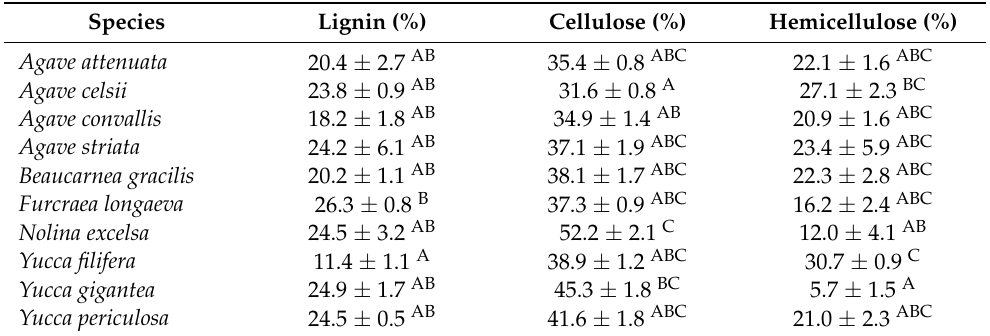
Table 4. Lignin, cellulose, and hemicellulose percentage of dry biomass of Asparagaceae